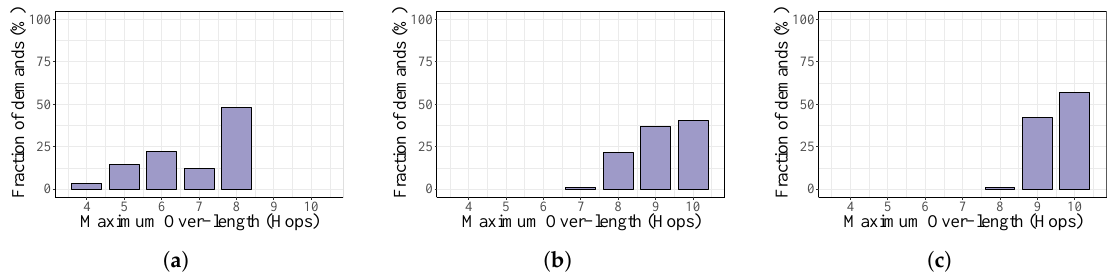
Figure 6. Distribution of maximum control traffic over-length in the New York topology for: ( a ) 1 controller, ( b ) 2 controllers and ( c ) 3 controllers.